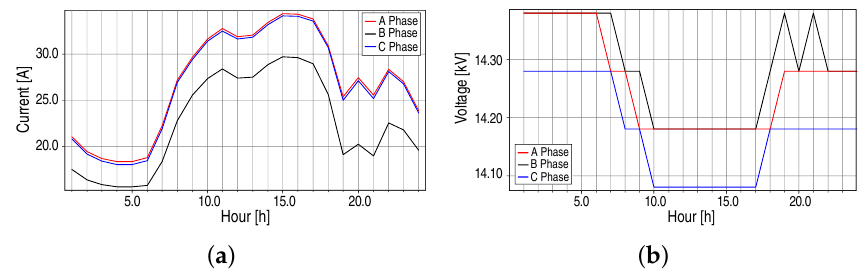
Figure 7. Simulated data: ( a ) current behavior and ( b ) voltage